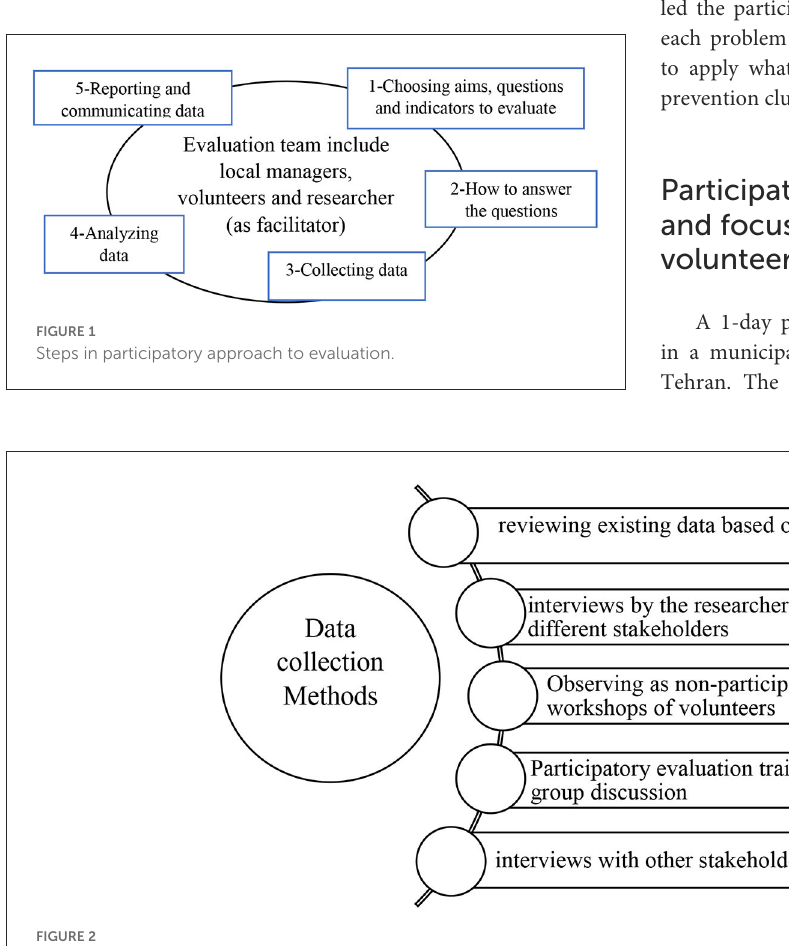
FIGURE2 Data collection methods used in evaluation of local obesity-prevention clubs in Tehran